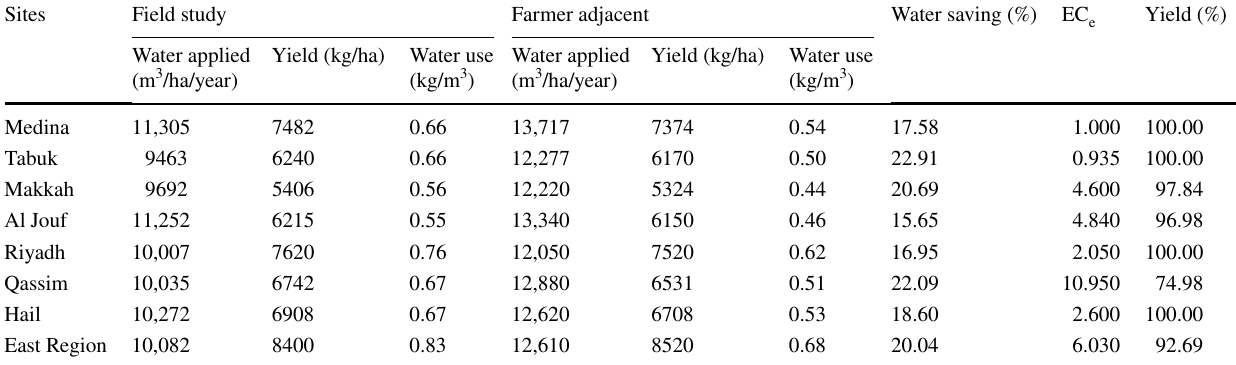
Table 5 Water use efficiency Kg/m 3 , yield Kg/ha and water saving ( %) in the field study compared to farmer adjacent